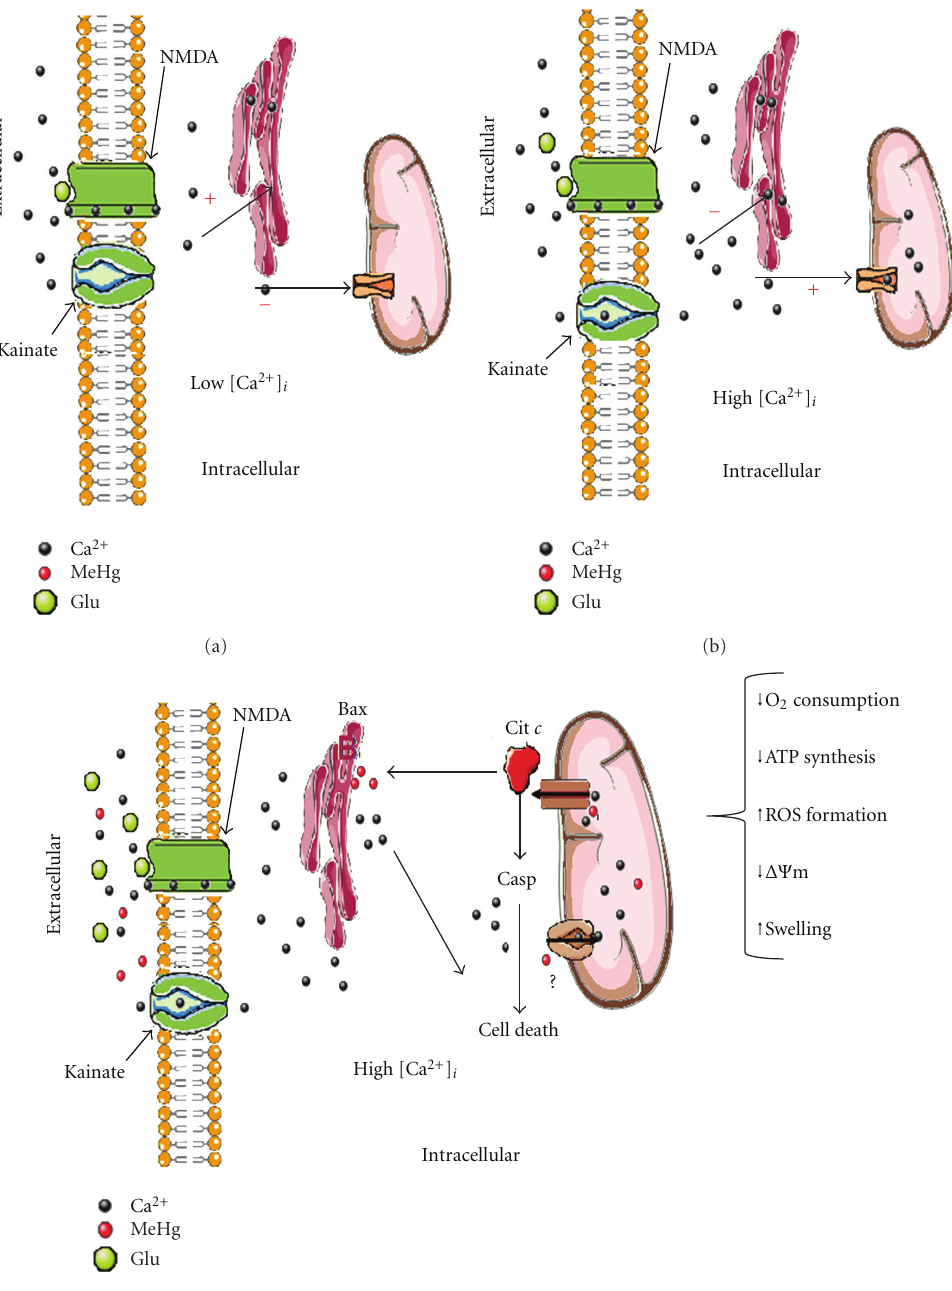
(c) Figure 5: Schematic representation on the role of mitochondria and SER as intracellular Ca 2+ stores and on the cellular death induced by MeHg via Ca 2+ dyshomeostasis. (a) Under low cytosolic [Ca 2+ ] i the SER preferentially moves Ca 2+ from cytosol due its high a ffi nity and low capacity to stores Ca 2+ ; whereas (b) the mitochondria by presenting low a ffi nity and high capacity to stores Ca 2+ moves it under high cytosolic [Ca 2+ ] i ; (c) the disruption of Ca 2+ regulation produced by MeHg in either of these stores can lead to release of neuronal proapoptotic factors that may trigger cell death pathways. The scheme presented here is merely representative, and the scale of the di ff erent cellular structures does not represent the real